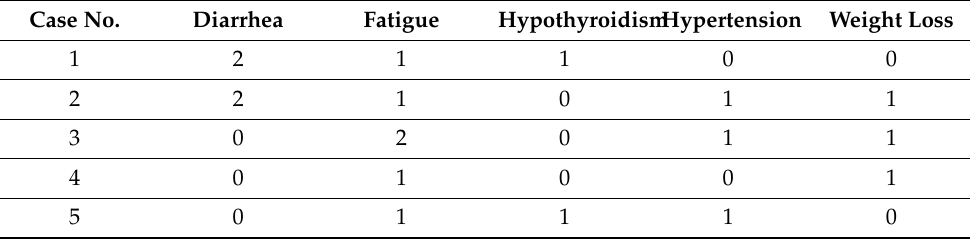
Table 2. Common adverse events (AE) seen in all five presented patients following treatment with lenvatinib plus pembrolizumab. The numbers indicate the grade of each AE in each specific patient. Case